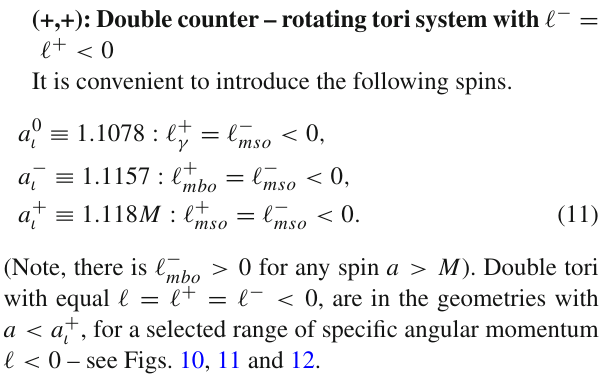
bounded orbit, (γ) indicates the marginally circular orbit. Particles energy ratio E (cid:2) / ˙ t and angular momentum L (cid:2) / ˙ t at the inversion points r ± (cid:2) ofEq.(9)(where u t = ˙ t )areshownfortwodifferentinversionplanes σ (cid:2) . (The most general solutions r ± σ (cid:2) are shown not considering (cid:2) and energy and momentum constraints of Sect.